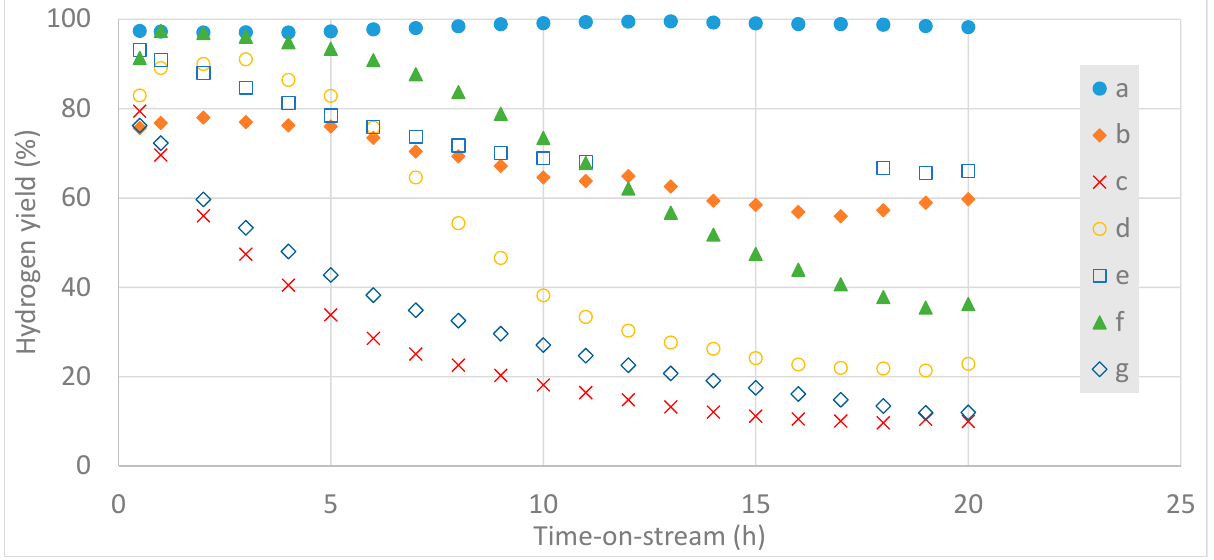
Figure 7. Hydrogen yield at 650 °C, feed 10 wt% glycerol in water. ( a ) La 0.3 Zr 0.7 NiO 3 ; ( b ) 10 wt% Ni/(0.3La 2 O 3 -0.7ZrO 2 ); ( c ) La 0.8 Sr 0.2 NiO 3 ; ( d ) CeNiO 3 ; ( e ) La 0.3 Ce 0.7 NiO 3 ; ( f ) 10 wt% Ni/(0.3La 2 O 3 –0.7CeO 2 ); ( g ) LaNiO 3 .